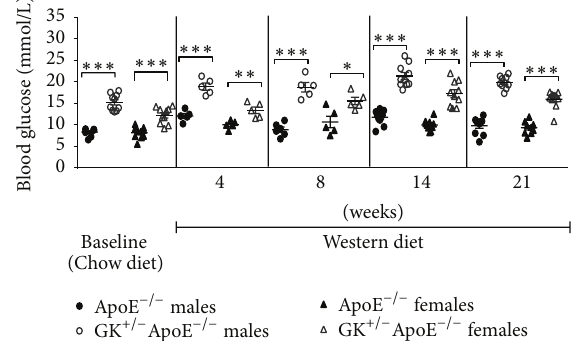
Figure 3: Fasting blood glucose is higher in GK +/− ApoE −/− mice on normal Chow diet and WD at 4, 8, 14, and 21 weeks compared with ApoE −/− mice. Values are presented as individual data points and means. Statistical analysis was performed using 𝑡 -test and a 𝑝 value of less than 0.05 was considered significant. ∗ 𝑝 < 0.05 , ∗∗ 𝑝 < 0.005 , and ∗∗∗ 𝑝 < 0.0001